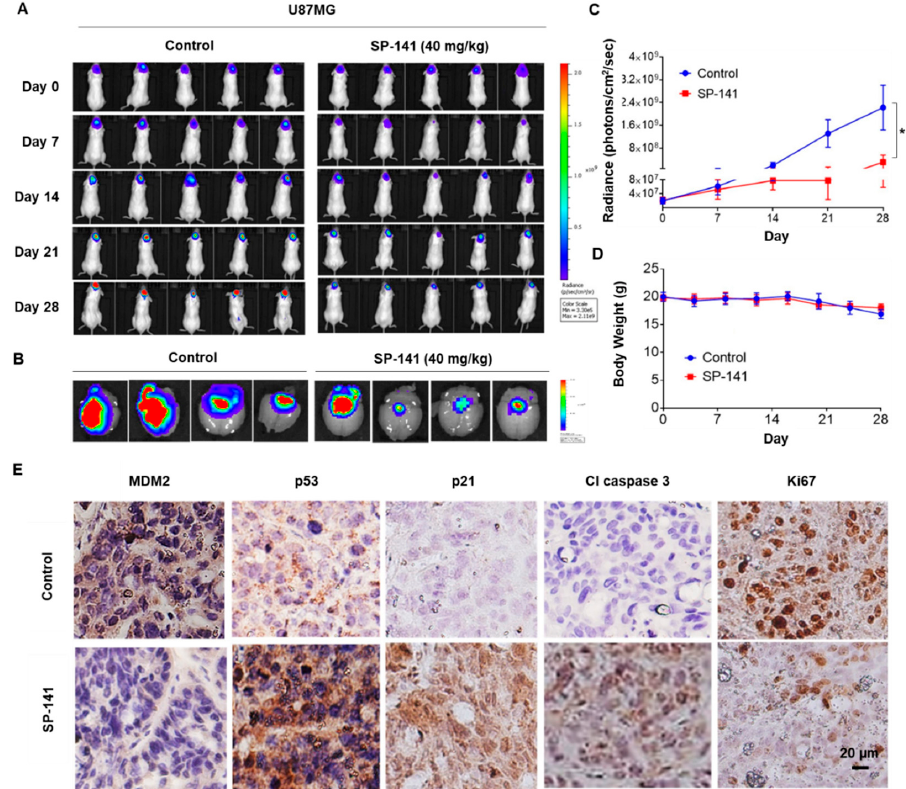
Figure 3. SP-141 shows excellent antitumor activity against U87MG human glioblastoma intracranial xenografts. ( A) Representative images of bioluminescence acquisition of the brain tumors in nude mice after 0, 7, 14, 21, and 28 days of treatment. SP-141 was administered intraperitoneally at 40 mg/kg/day, 5 days per week for 4 weeks. SP-141 was dissolved in PEG400/EtOH/saline (57.1:14.3:28.6, v / v / v ). The control group received the vehicle alone. ( B ) Ex-vivo bioluminescence from the brains of control (left panel) and SP-141-treated (right panel) mice. The scale indicates the fluorescence intensity in terms of radiant efficiency (p/sec/cm 2 /Sr). ( C ) Average time-dependent changes in bioluminescence radiance in U87MG xenografts in mice receiving SP-141 therapy over 4 weeks (* p < 0.01). ( D ) The average body weights of mice were plotted during SP-141 treatment. ( E ) Reduced MDM2 expression and activation of p53 signaling components were observed in U87MG intracranial xenografts following SP-141 treatment. Brain areas bearing the U87MG tumors from control and SP-141 treated nude mice were sectioned and processed for the expression of MDM2, p53, p21, cleaved caspase 3, and Ki67 proteins by immunohistochemistry. Representative staining patterns are shown. Scale bars: 20 µ